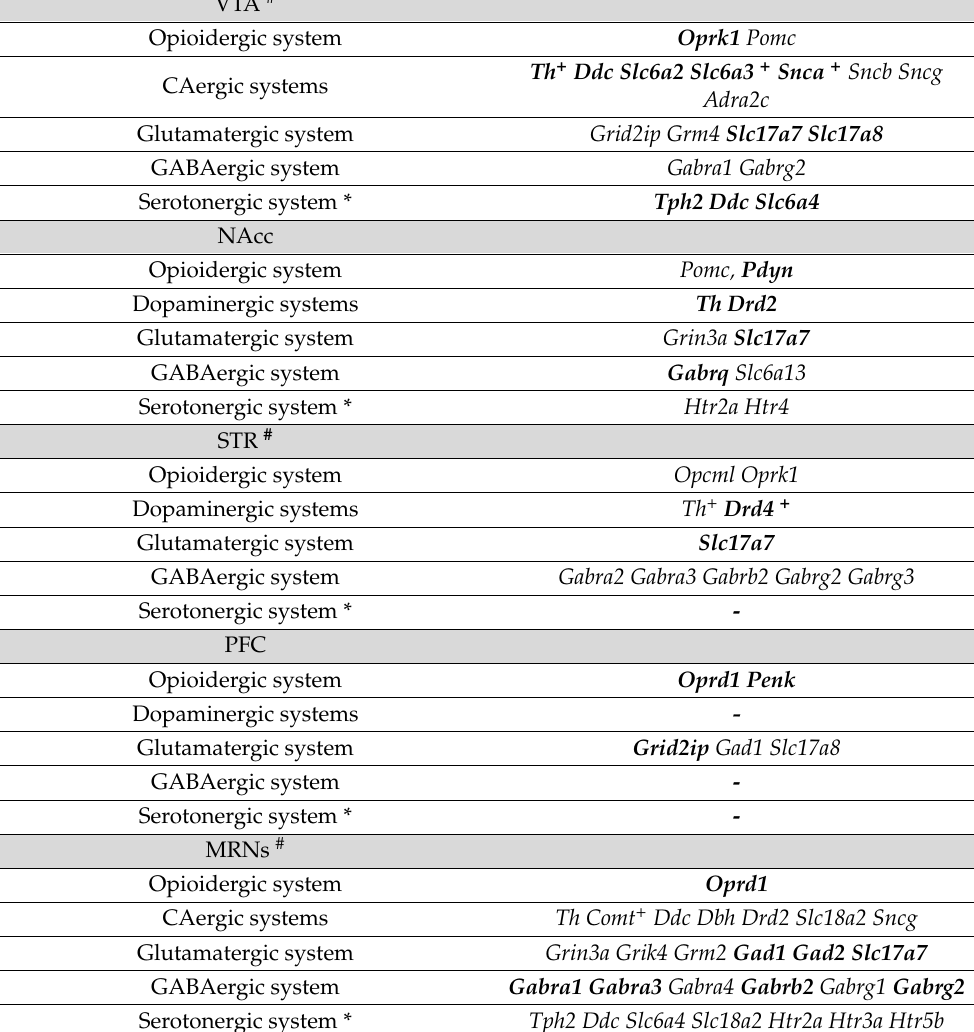
Table 2. DEGs in brain regions of the mice with positive fighting